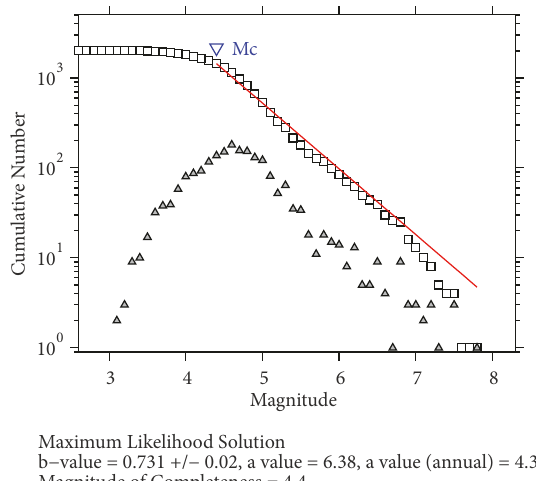
Figure 6: Magnitude distribution graph of seismicity in ENTP.